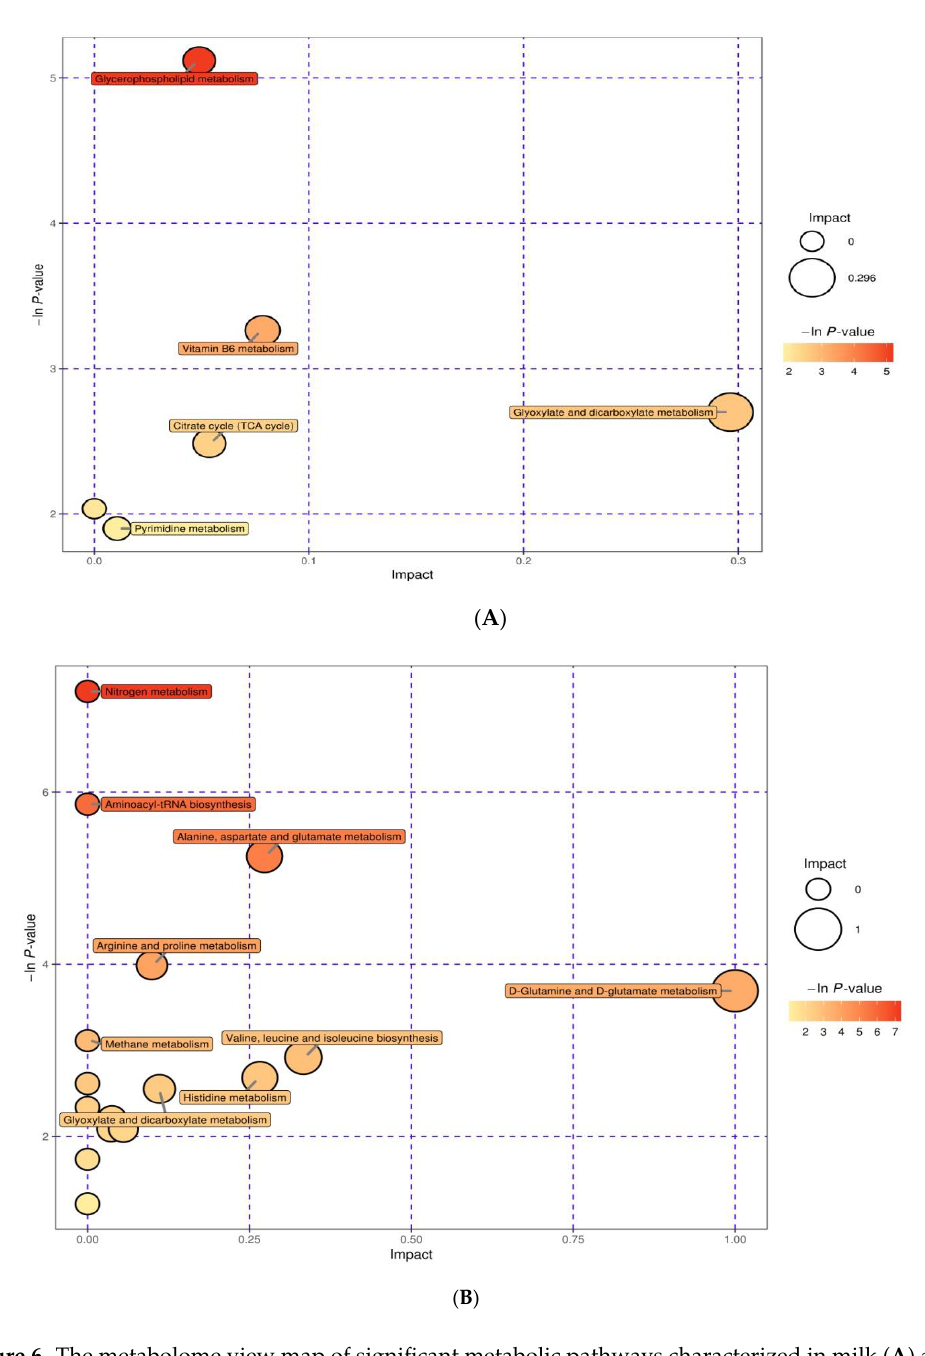
Figure 6. The metabolome view map of significant metabolic pathways characterized in milk ( A ) and plasma ( B ) for cows from the HS (heat stress) and TN (thermoneutral) periods. This figure tries to find pathways that were significantly changed based on enrichment and topology analysis.